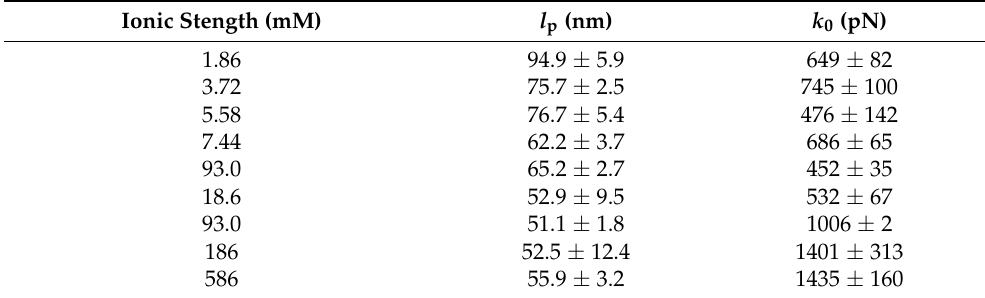
Table 6. Elasticity parameters of λ -bacteriophage DNA for different ionic strengths of NaCl concen- tration. Reprinted/adapted with permission from Ref. [186]. Copyright 1997, Natural Academy of Sciences. Ionic Stength